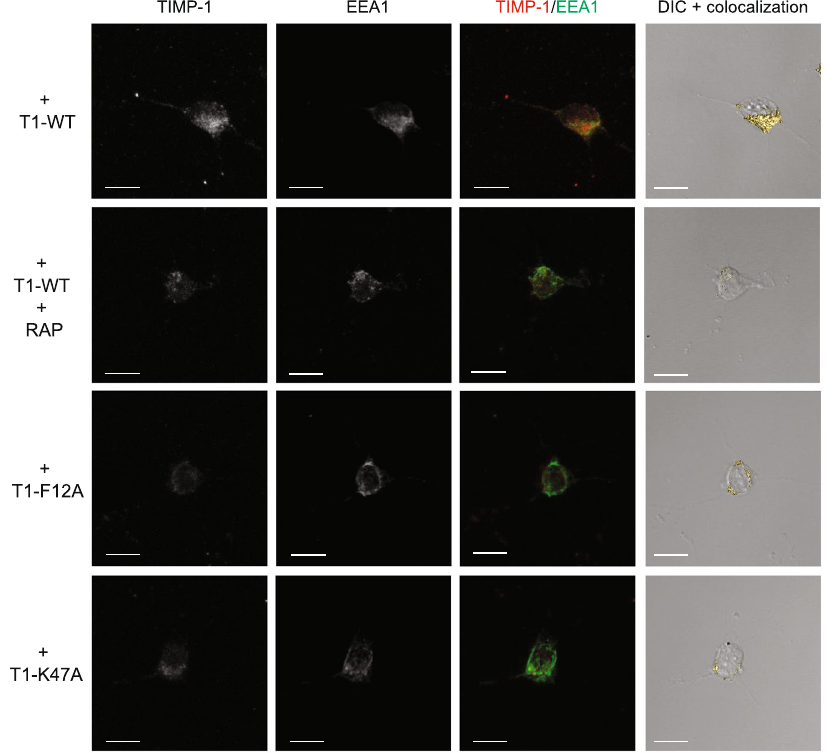
Figure 7. Confocal analysis of LRP-1-mediated endocytosis. Cortical neurons from mouse embryos cultured for 24 h on poly-L-lysine-coated coverslips were incubated at 4 °C for 30 min with 5 nM T1-WT, T1-F12A or T1K47A in the presence or absence of 500 nM RAP and then incubated at 37 °C for 10 min. Cells were stained with Alexa Fluor 488 for TIMP-1 and Alexa Fluor 568 for EEA1 and analysed by confocal microscopy. Images were treated with AMIRA software. Maximal Intensity Projection (MIP) in greyscale of TIMP-1 labelling (first panel) and EEA1 labelling (second panel), TIMP-1/EEA1 merge (third panel, TIMP-1 in red and EEA1 in green), differential interference contrast (DIC) and isosurface representation of TIMP-1/EEA1 colocalisation (fourth panel) are shown. Images are representative of more than three distinct experiments. Scale bar: 10 µ